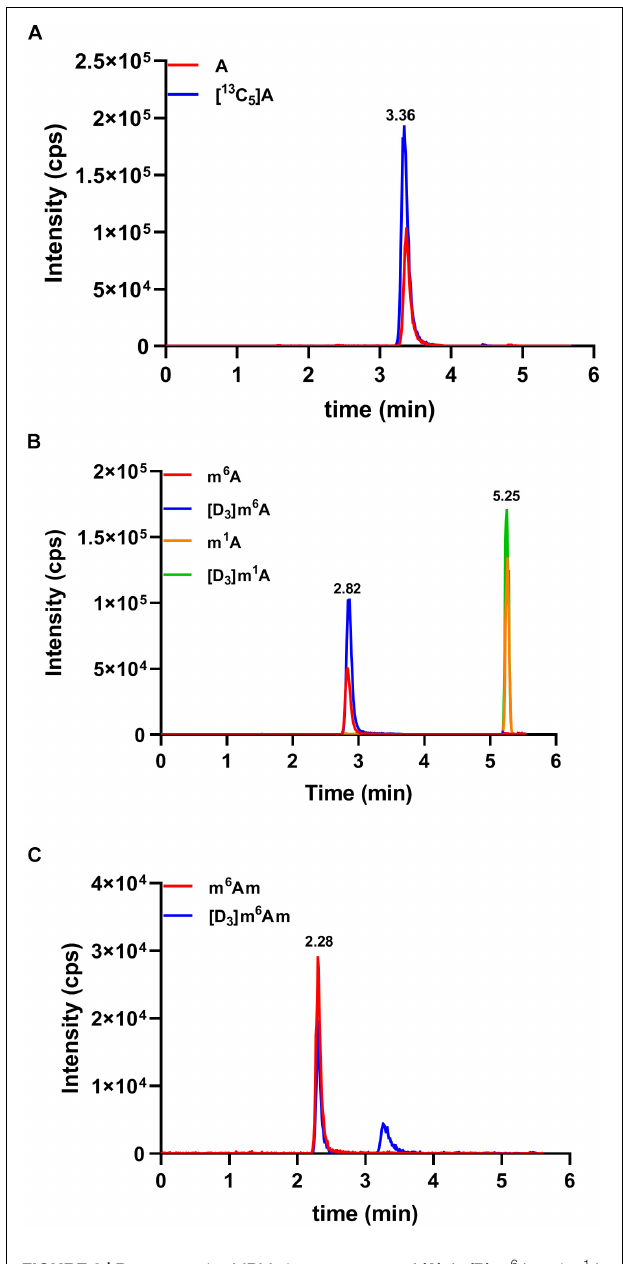
FIGURE 3 | Representative MRM chromatograms of (A) A, (B) m 6 A and m 1 A, (C) m 6 Am, and spiked isotope-labeled internal standards in a serum sample.